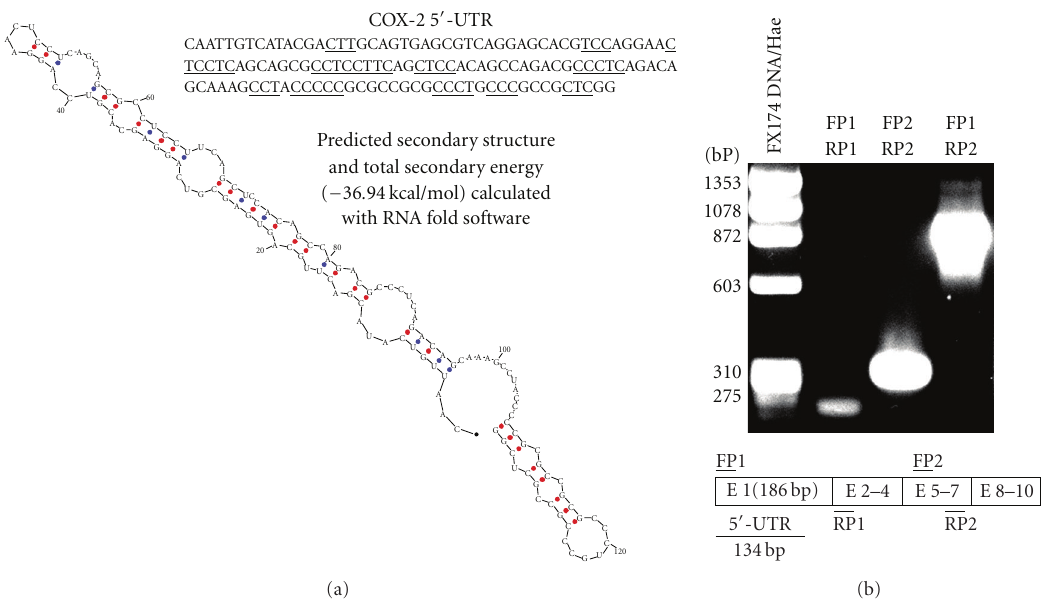
Figure 2: Sequence of the 5 (cid:2) -UTR of COX-2. The sequence and the predicted secondary structure of the 5 (cid:2) -UTR of COX-2 calculated using RNAfold software are shown. Polypyrimidine tracts are underlined in the sequence (a). Agarose gel electrophoresis of PCR reactions in RNA obtained from resting PMN using di ff erent combinations of primers (b). Stick diagrams show the location of primers used for PCR reactions, and the lanes are marked according to the combination of primers selected to carry out the reactions. FP indicates forward primer, RP indicates reverse primer. Reproduced with permission